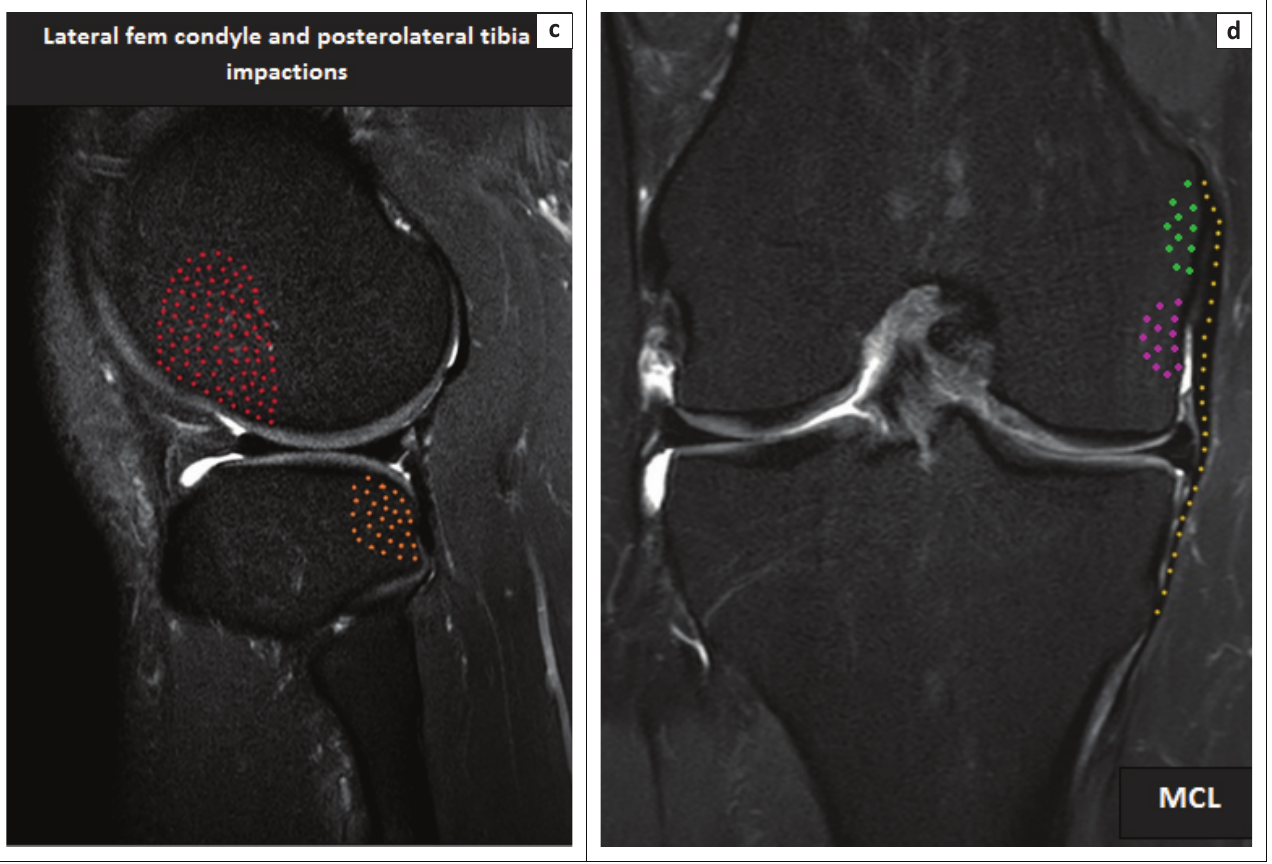
FIGURE 6 (Continues ...): Flexion, valgus and external rotation: (a) Schematic depicts excessive sudden internal rotation of femur on ‘fixed’ tibia (effective external tibial pivot) with knee in flexed valgus position, (b) anterior cruciate ligament (ACL) tear that results from excessive rotation, (c) non-contiguous impactions at the lateral femoral condyle and posterolateral tibia that occur once the ACL has given way and (d) right knee medial collateral ligament (MCL) tear which is often incomplete; look for avulsion bone bruise at deep (purple) and superficial (green) MCL portion